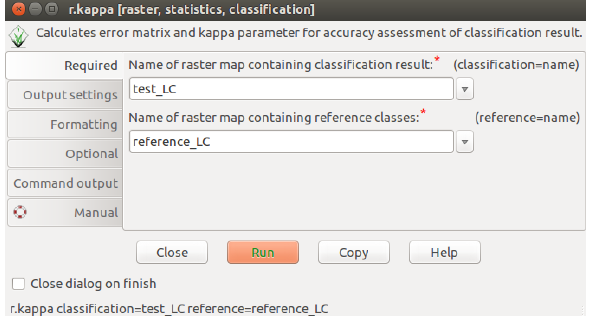
Figure 3. Interface of the GRASS GIS module